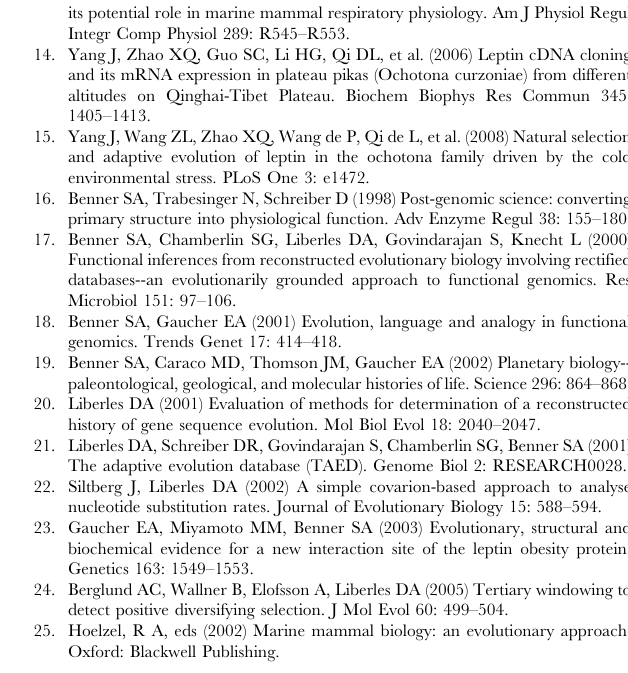
Figure S4 NJ trees based on LPR alignment (3519 nt; 24 sequences). MP and Bayesian analyses (AIC model: TVM + G; Base frequencies: A=0.2723; C=0.2327; G=0.2286 and T=0.2665;